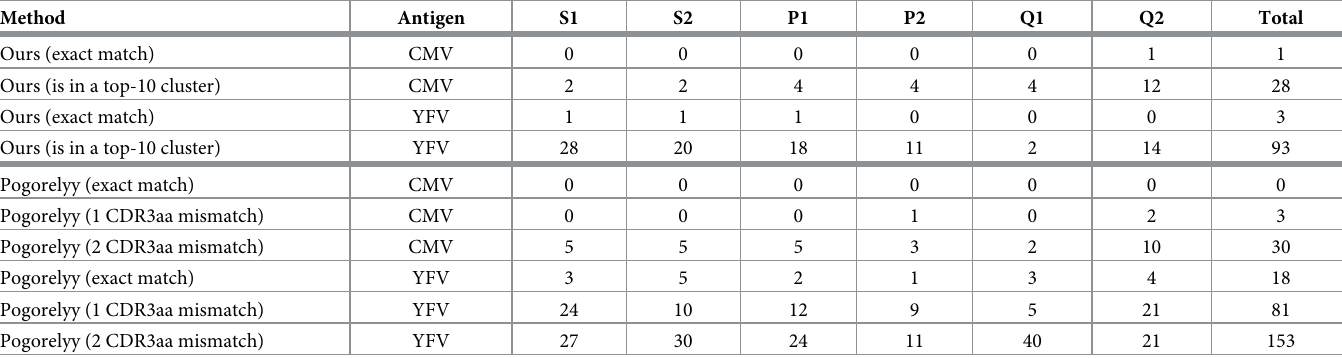
Table 1. Counts of matches between our inferred responsive yellow fever (YFV) sequences and either (YFV) or cytomegalovirus (CMV) sequences obtained from VDJdb, where the CMV sequences are used as a control. Also provided are analogous counts for responsive sequences inferred by Pogorelyy et al. [20]. Columns S1—Q2 correspond to the six subjects discussed in [20], also discussed in the Materials and Methods